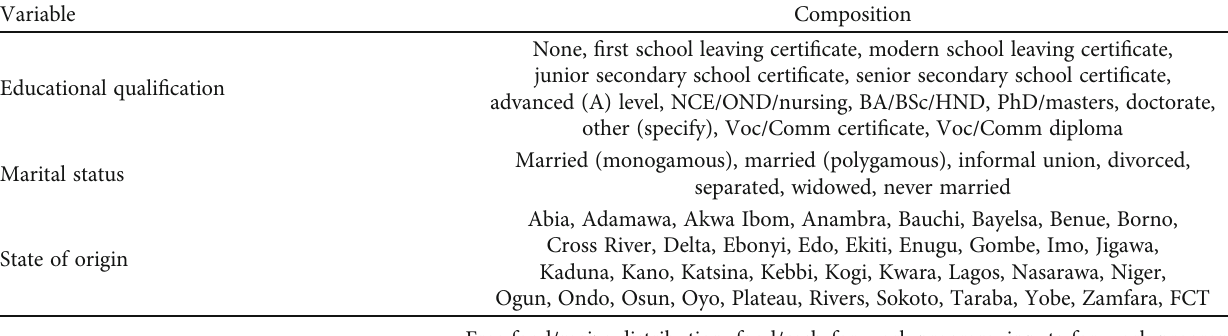
Table 2: Variables and measurement.